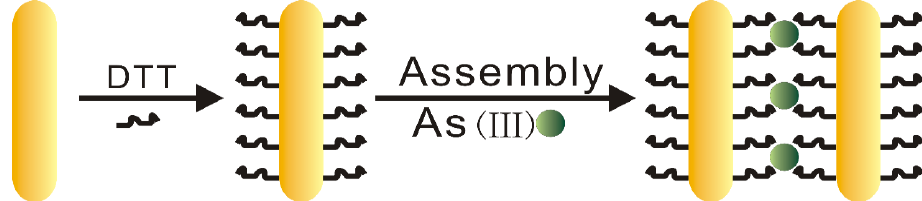
Figure 1. The schematic mechanism of determination of As(III) by DTT-AuNRs colorimetric probe.